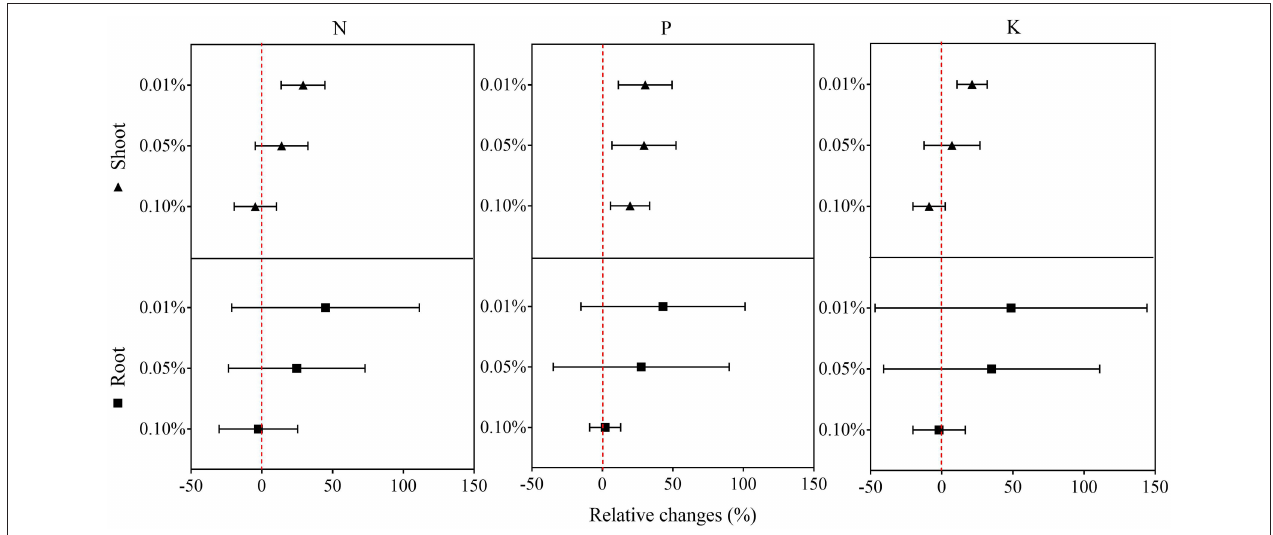
FIGURE 3 | Relative changes in the N, P, and K uptake of shoots and roots across 0.01, 0.05, and 0.1% dosages in Experiment 2a ( n = 4).